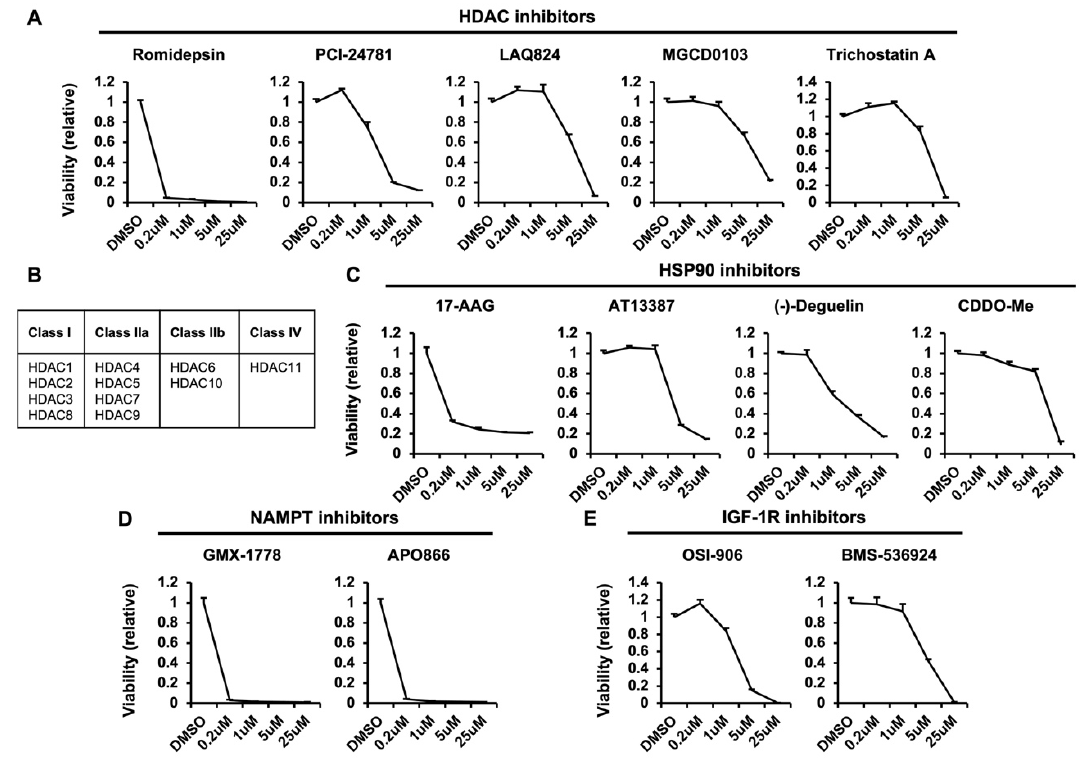
Figure 3. Positive regulators of macropinocytosis-dependent growth. ( A ) Relative viability of cells treated with various concentrations of the HDAC inhibitors romidepsin, PCI-24781, LAQ824, MGCD0103, and trichostatin A. ( B ) Box indicating the distinct classes of the HDAC family and their constituent members. ( C ) Relative viability of cells treated with various concentrations of the HSP90 inhibitors 17-AAG, AT13387, (-)-Deguelin, and CDDO-Me. ( D ) Relative viability of cells treated with various concentrations of the NAMPT inhibitors GMX-1778 and APO866. ( E ) Relative viability of cells treated with various concentrations of the IGF-1R inhibitors OSI-906 and BMX-536924.